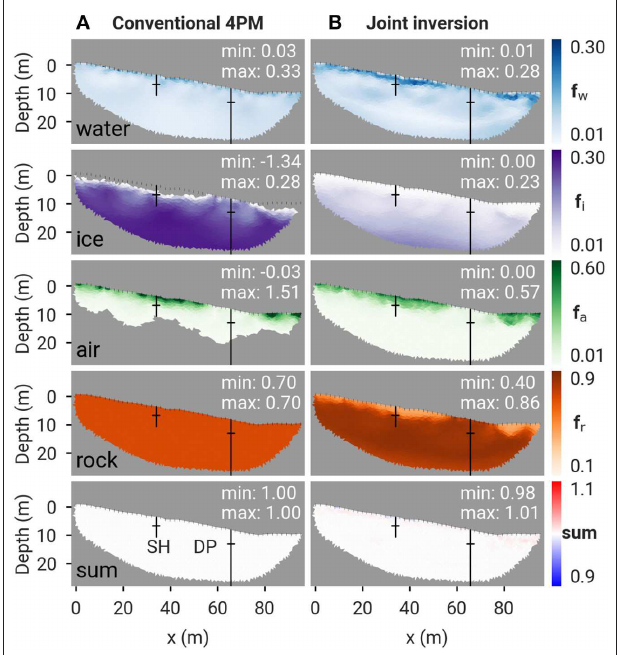
FIGURE 4 | Resulting phase fractions and their sum for the Cervinia field site for (A) the conventional 4PM and (B) the PJI (using Archie’s law in both cases). Boreholes and associated thaw depths are marked by black lines. Minimum and maximum phase fractions are indicated for each tomogram.